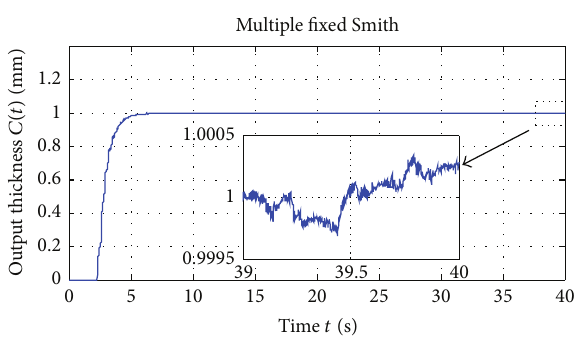
Figure 8: Multiple fixed Smith prediction model.